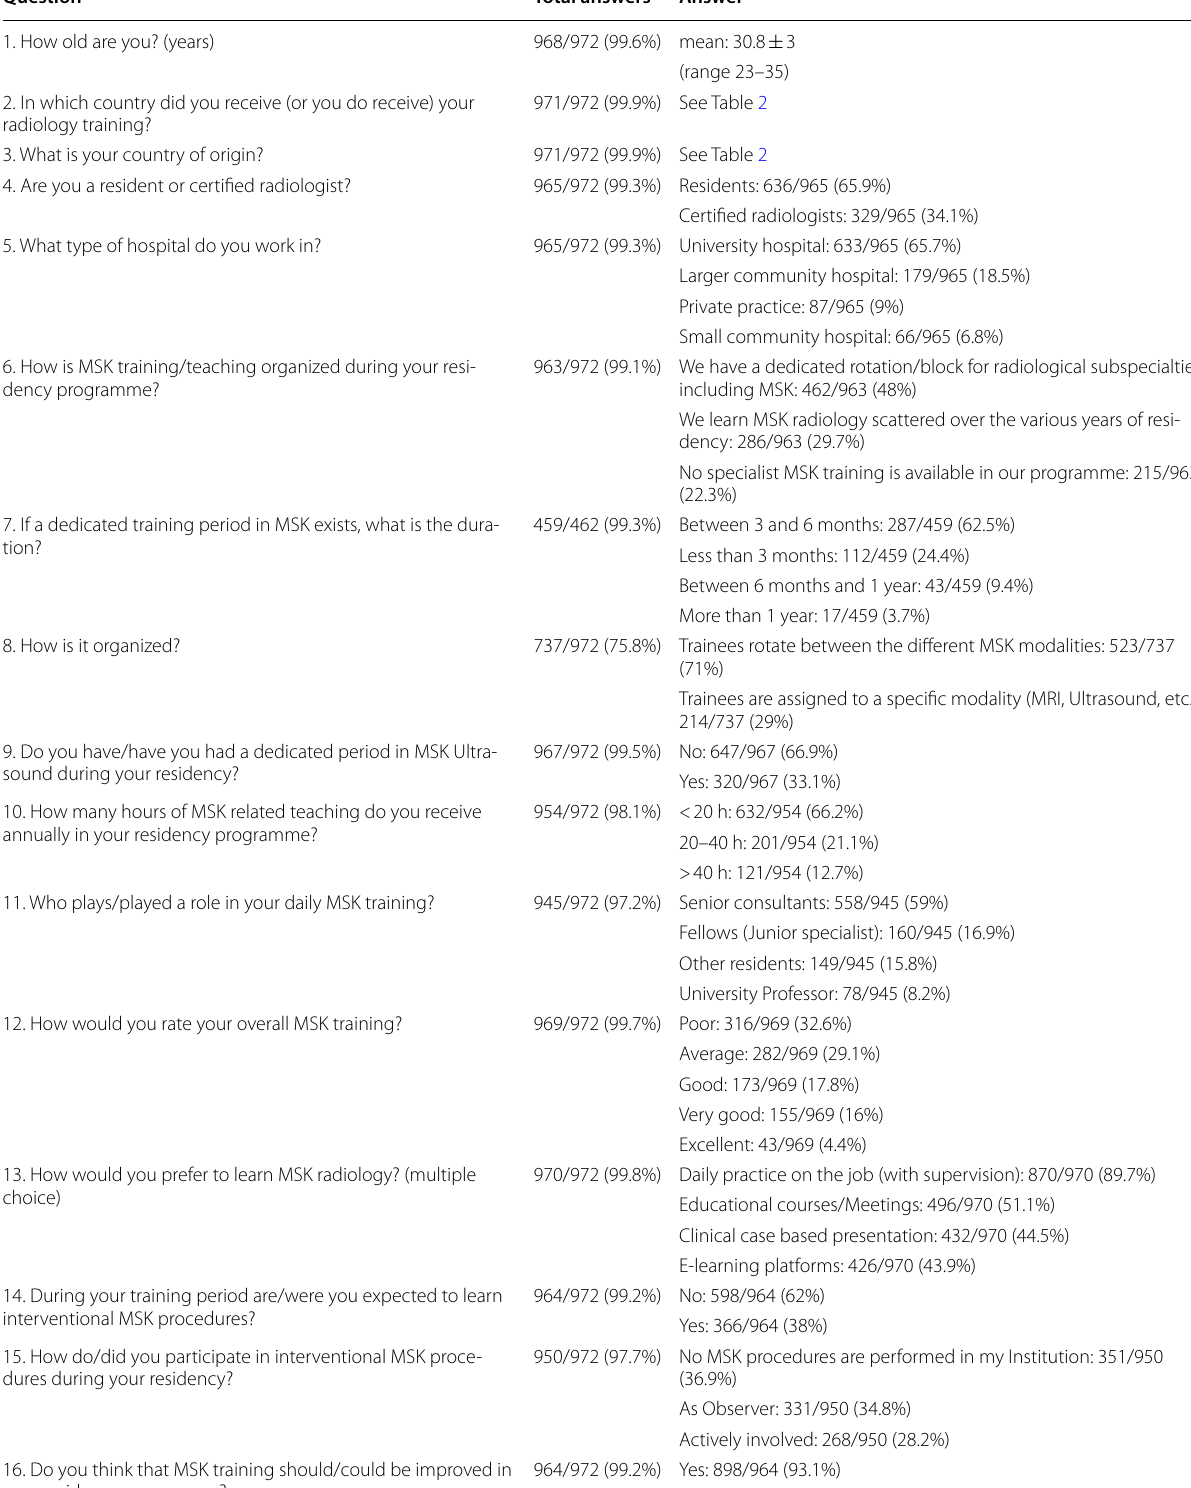
Table 1 Full list of questions included in the survey and pertinent answers from 972 participants